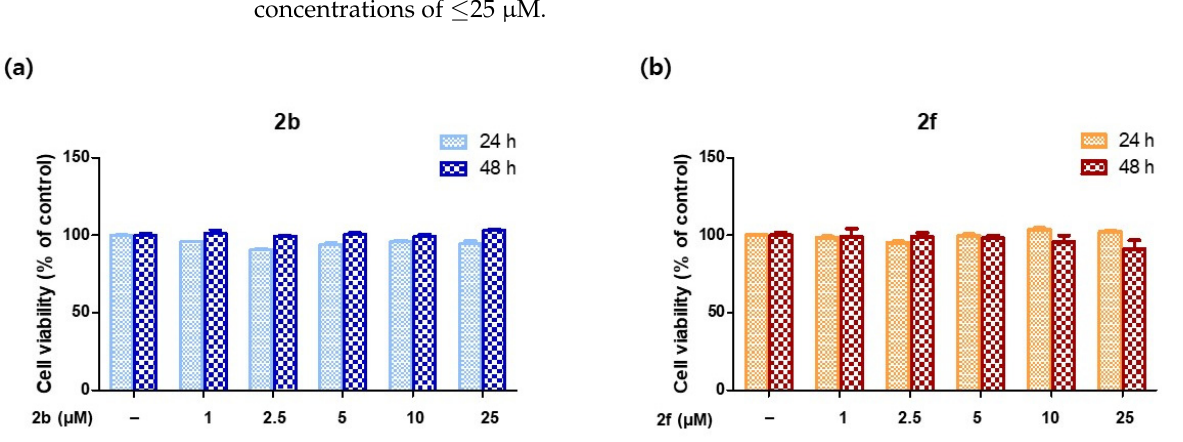
Figure 7. The cytotoxic effects of compounds 2b ( a ) and 2f ( b ) on B16F10 melanoma cells at concentrations of 1, 2.5, 5, 10, or 25  M. Cell viabilities were determined using the EZ-Cytox assay and are expressed as percentages versus non-treated controls. Bars present standard errors.